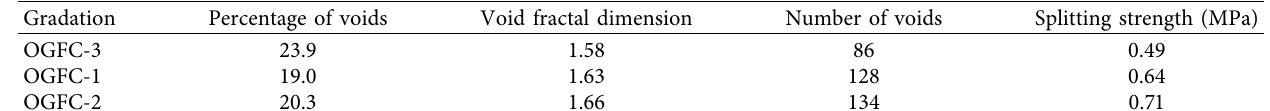
Figure 10: Fractal dimension distribution of different types of OGFC. Table 8: Splitting strength of different gradation specimens.